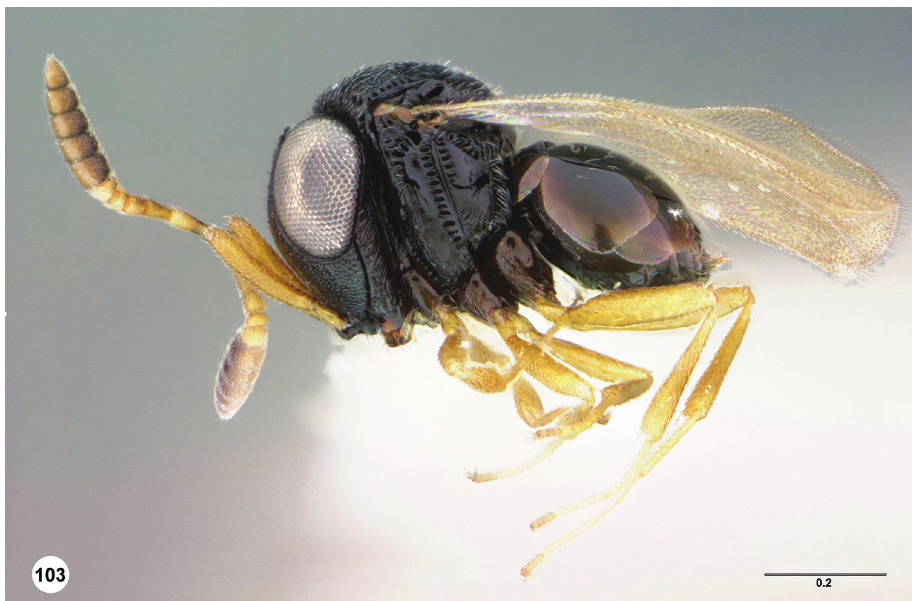
Figure 103. Trissolcus levicaudus female holotype (OSUC 144511), head, mesosoma, metasoma, lateral view. Scale bars in